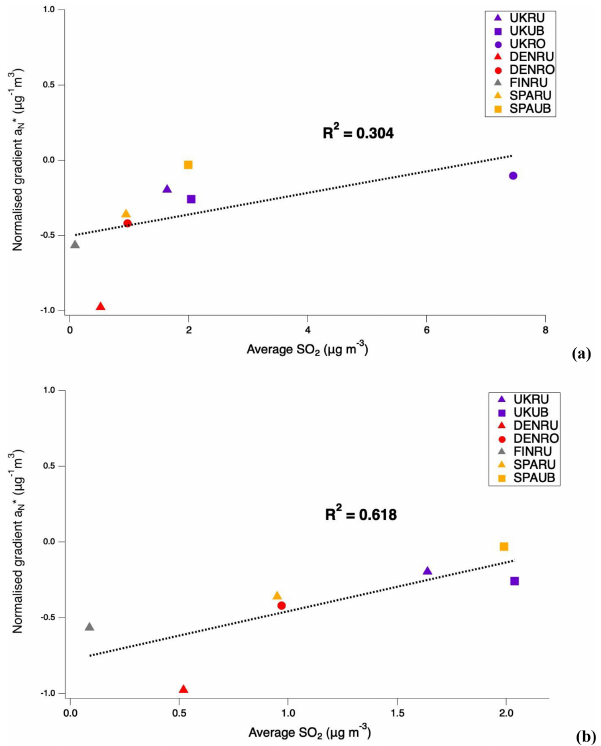
Figure 7. Relationship of average SO 2 concentrations and nor- malised gradients a ∗ for the sites with available data (a) and for N the sites with available data excluding UKRO (b)